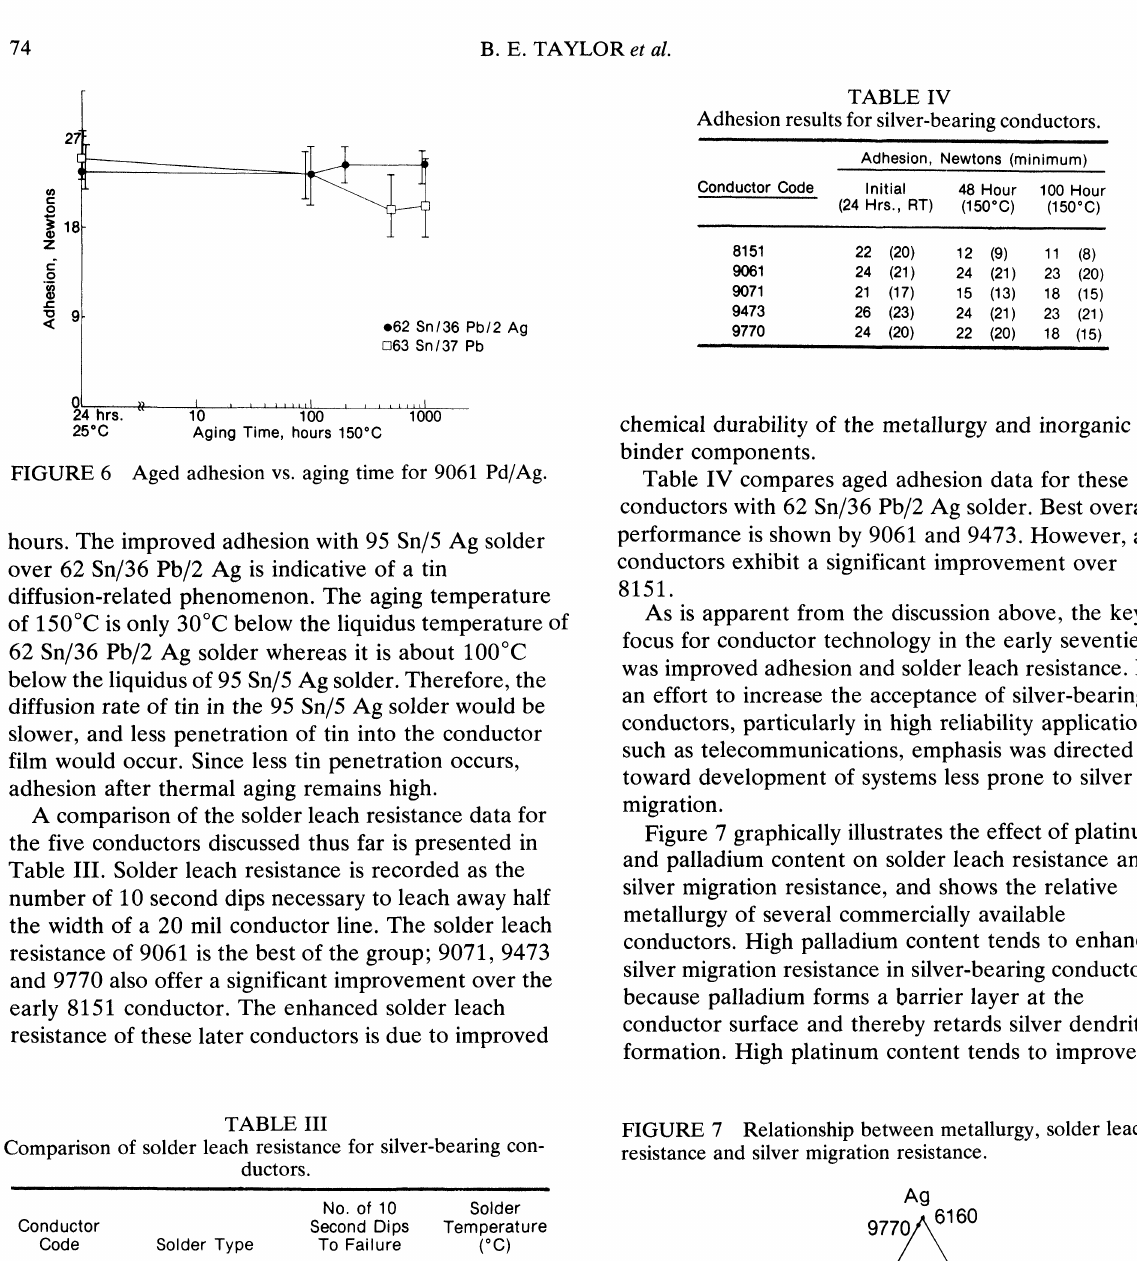
FIGURE 7 Relationship between metallurgy, solder leach resistance and silver migration